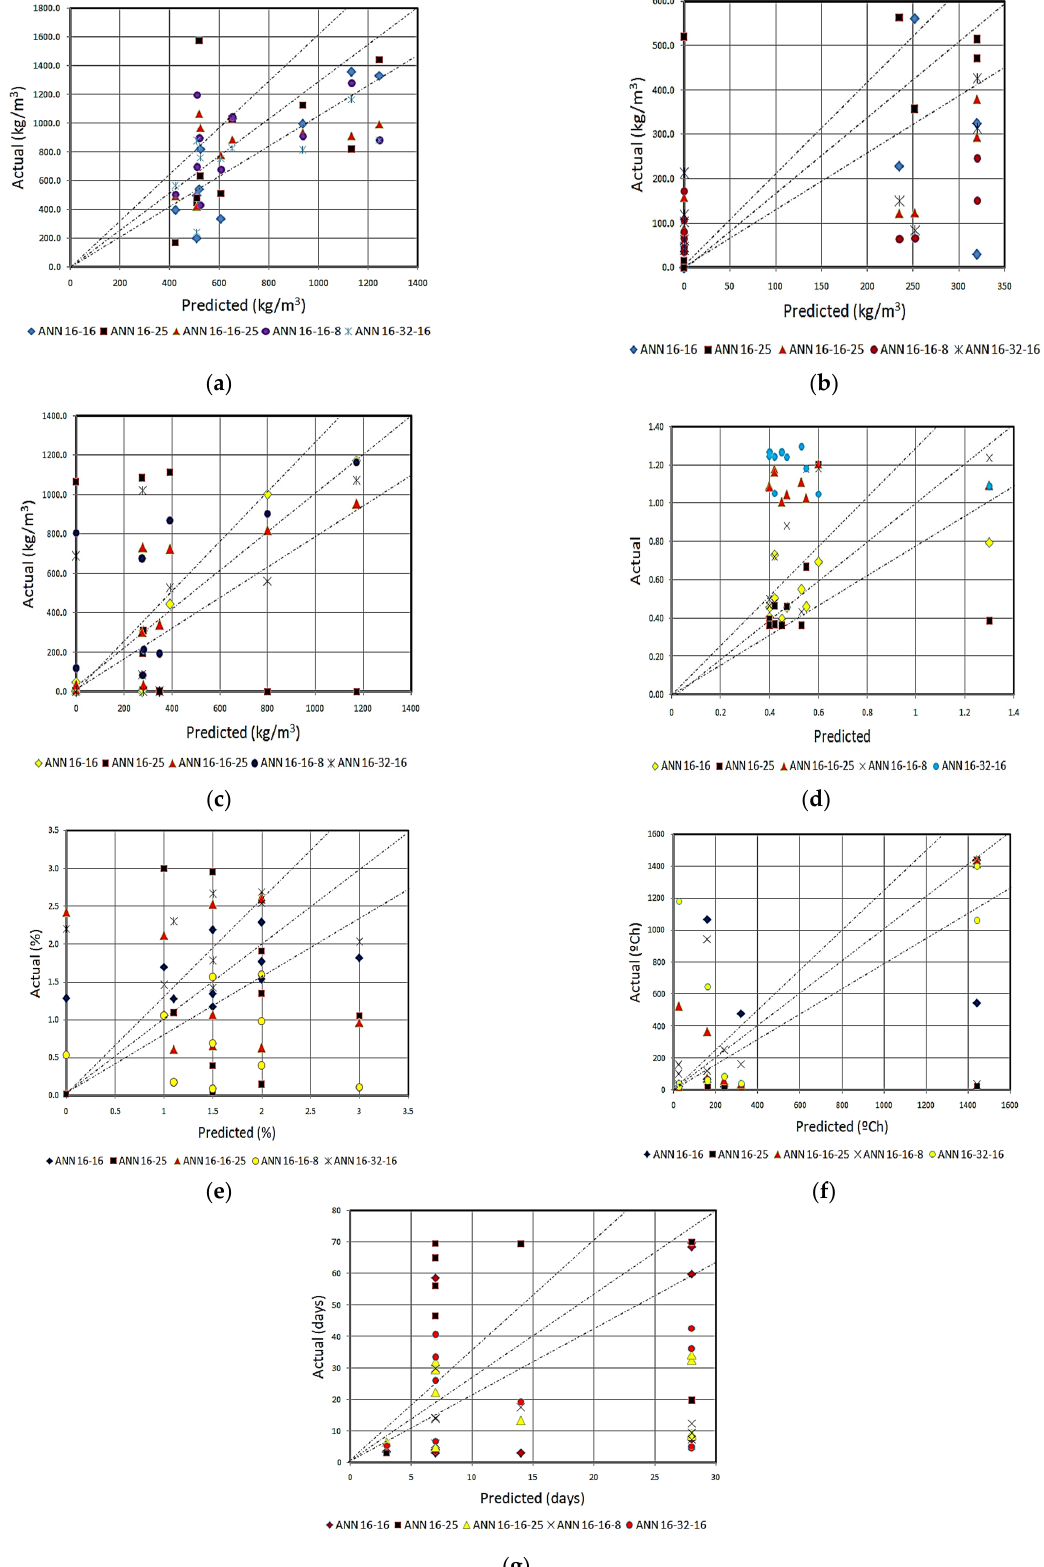
Figure 5. ( a ) Fly ash prediction; ( b ) GGBS prediction; ( c ) sand prediction; ( d ) activator/binder ratio; ( e ) PVA fiber (%) prediction; ( f ) curing temperature x hours prediction; ( g ) ambient curing days